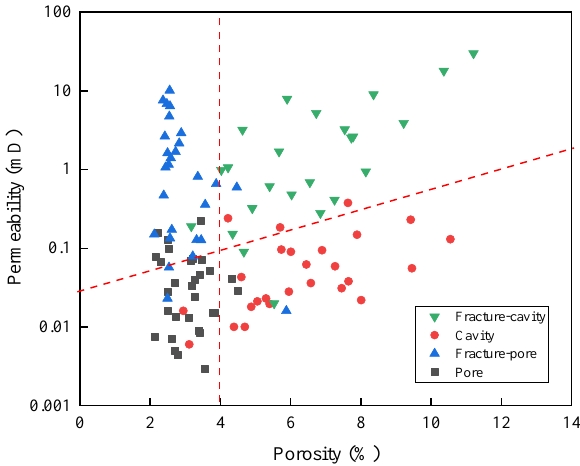
Figure 3. Relationship between the sample porosities and permeabilities.